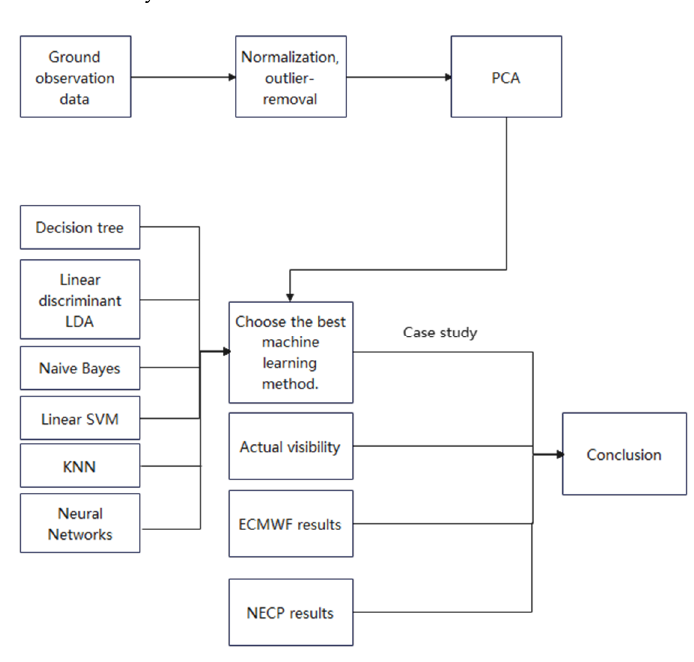
Figure 1. Methodology employed to predict and compare visibility.